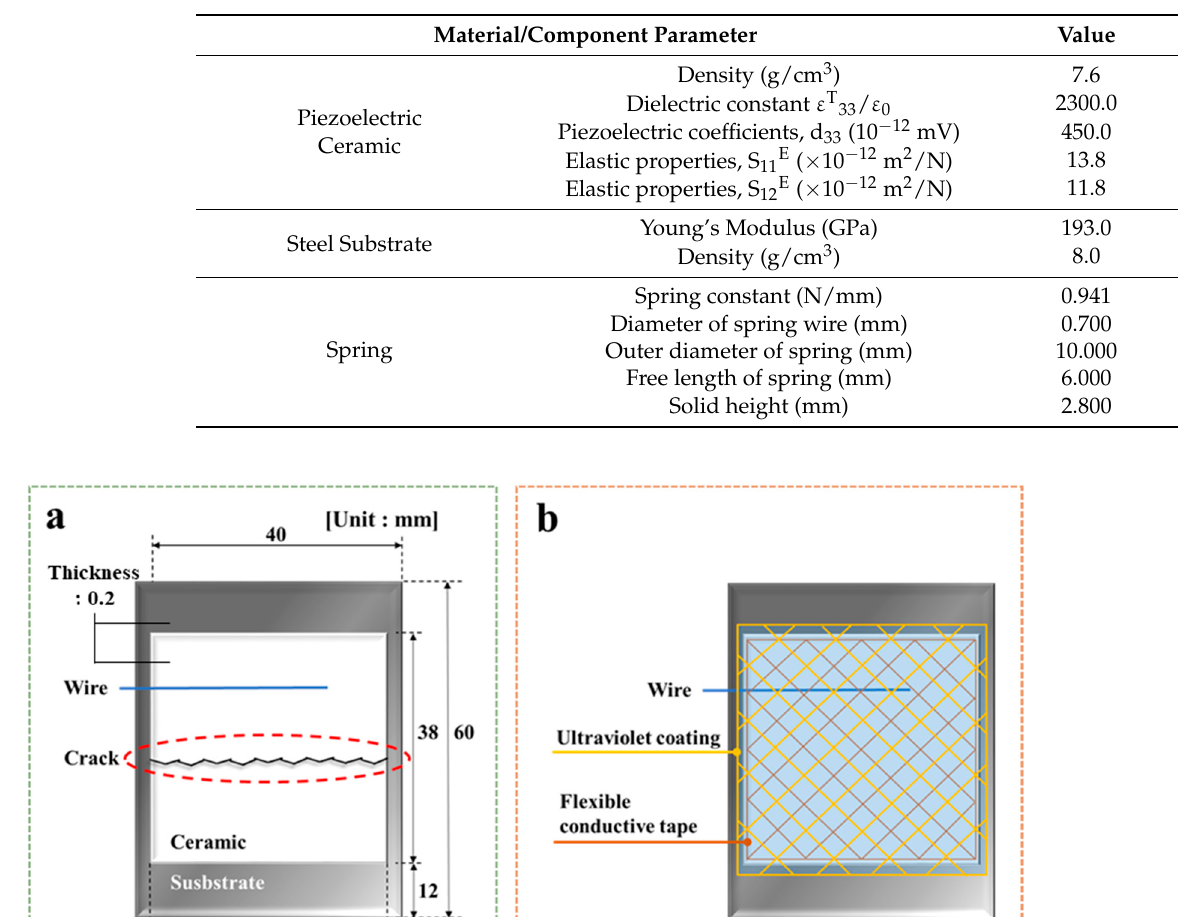
Table 1. Material and component properties.